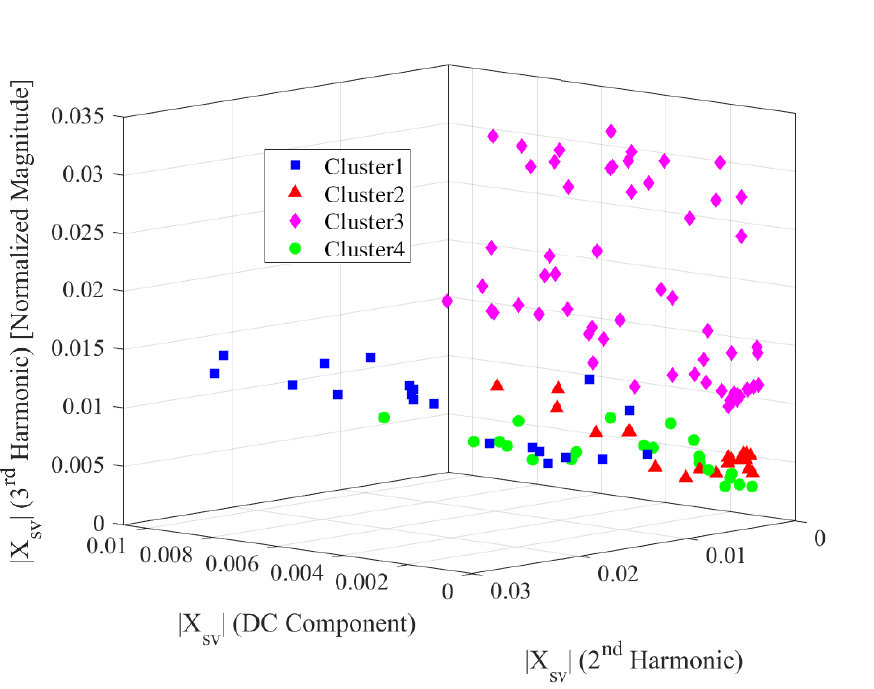
Figure 13. Scatter plot of stator voltage harmonics as feature data.